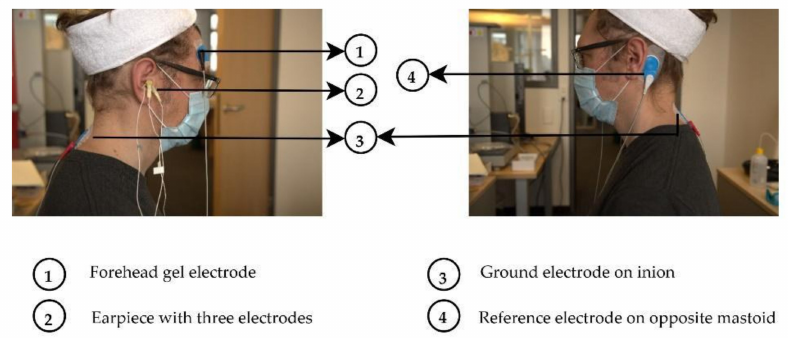
Figure 4. EEG recording setup on a subject. The ground was located at the inion, the reference at the contra-lateral mastoid.